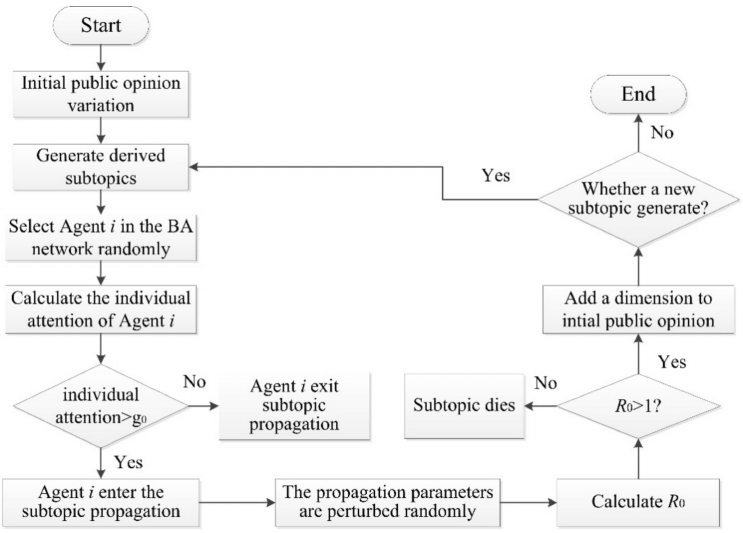
Figure 5. Multi-dimensional public opinion